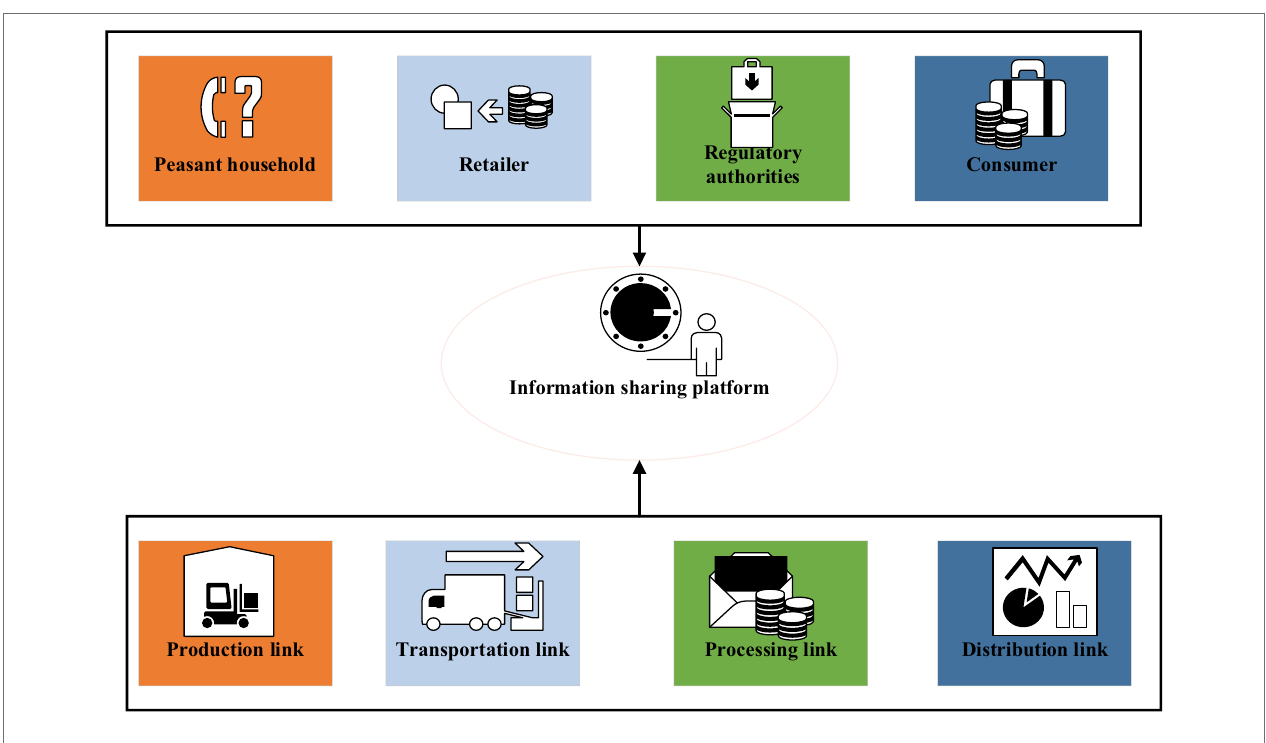
FIGURE 17 | Internet of Things technology in the field of food